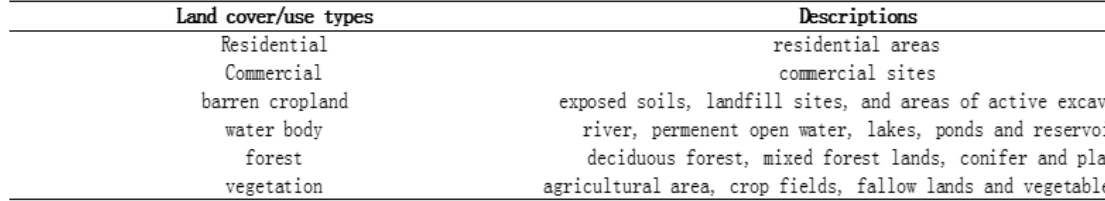
Table 3 . Classification categories and